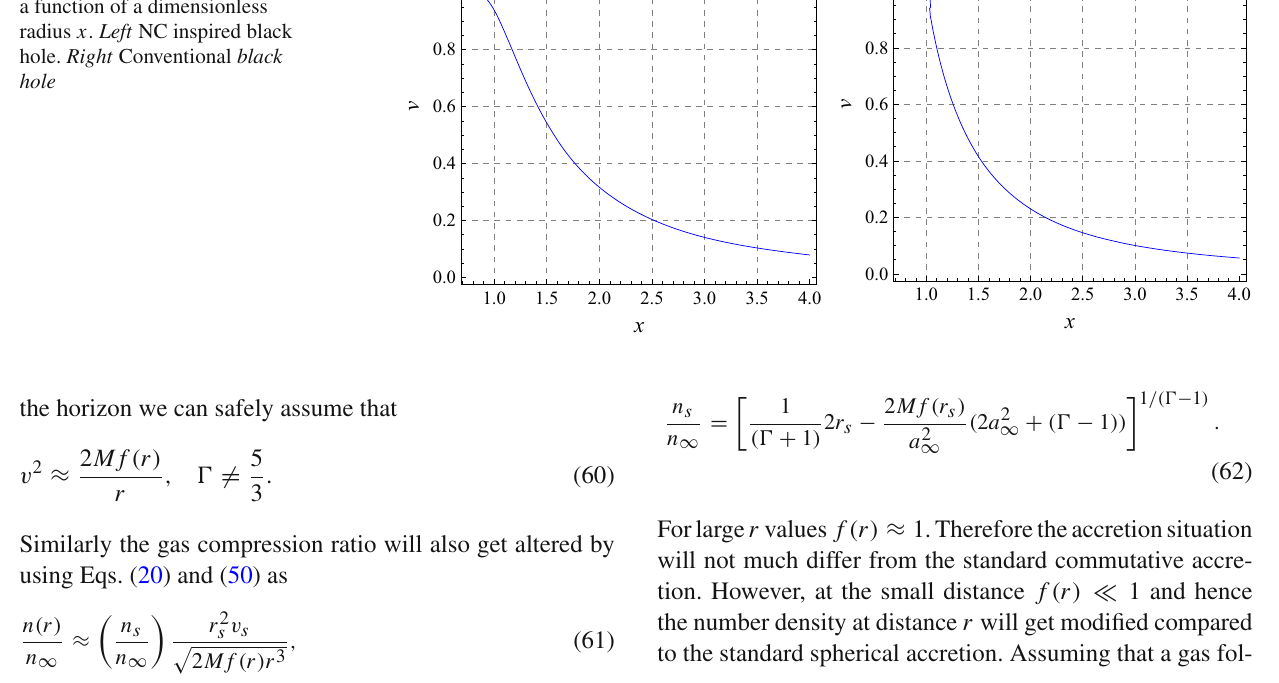
Fig. 3 Plot showing the radial velocity profile v for a fluid (cid:12) = 1 . 5 accreting onto the noncommutation inspired black hole as a function of the dimensionless radius x Fig. 4 The radial velocity profile v for a fluid (cid:12) = 1 .